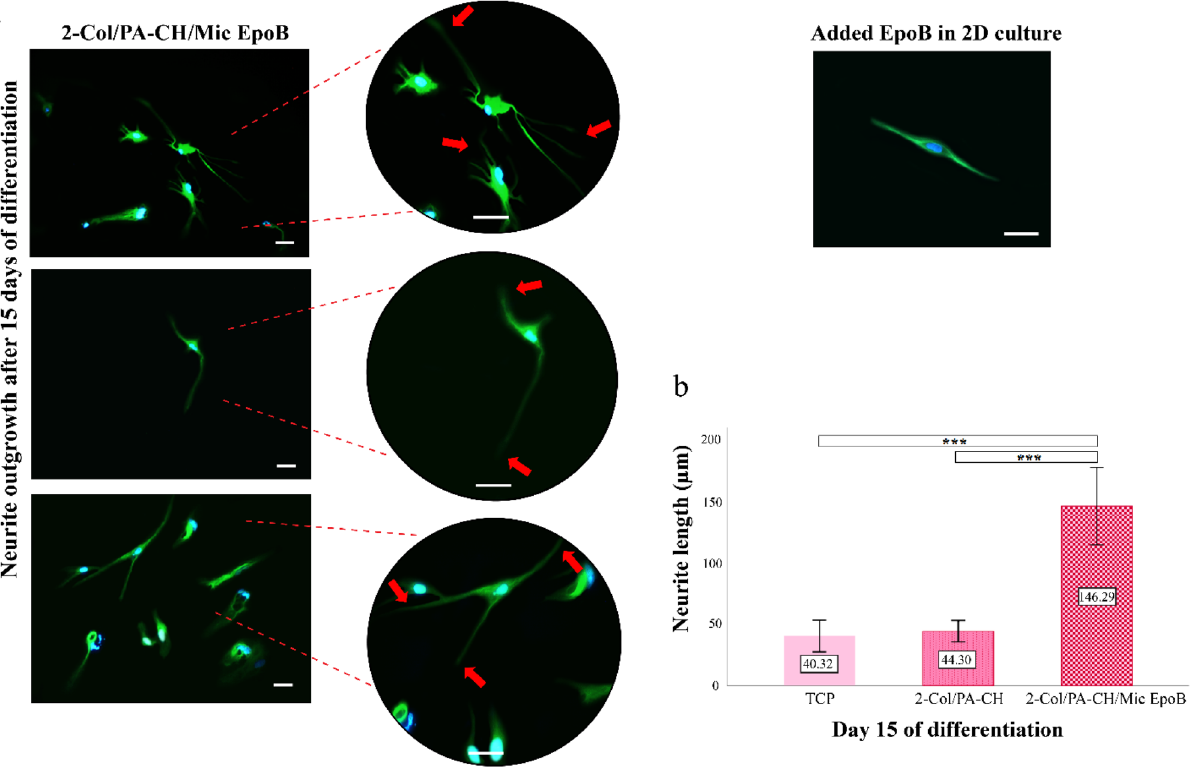
Figure 9. Neuronal morphology and neurite outgrowth. ( a ) Immunofluorescence images indicate neuronal morphology and neurite elongation of MN-like differentiated hEnSCs after 15 days of induction in collagen hydrogel with Mic EpoB (2-Col/PA-CH/Mic EpoB) group. ( b ) Neurite elongation is shown with red arrows. To display morphology, cells were stained using primary anti-beta III tubulin antibody and secondary Alexa Fluor 488 antibody (× 20 and × 40; Scale bar 100 μm). Neurite length of MN-like cells in 2-Col/PA-CH/Mic EpoB hydrogel compared to TCP and 2-Col/PA-CH differentiation groups at day 15 after differentiation (***P <